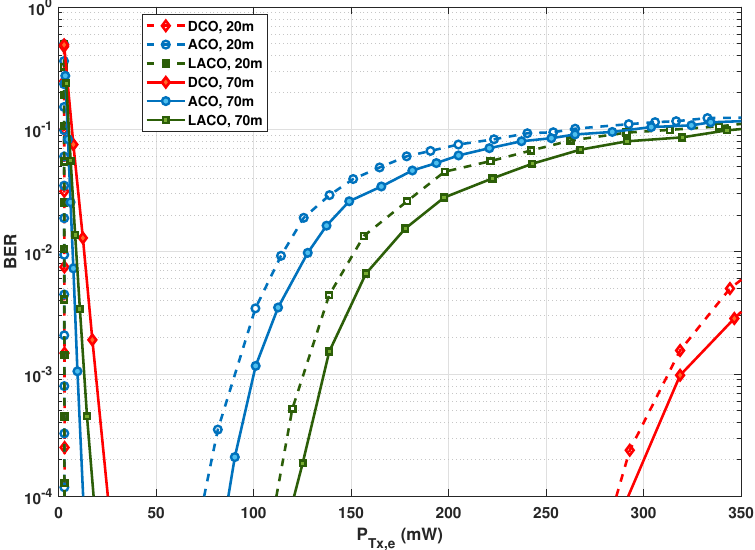
Figure 6. Contrasting clipping effect on DCO-, ACO-, and LACO-OFDM BER performances for Z = 20 and 70m. R b = 20Mbps, N = 1024, N CP =